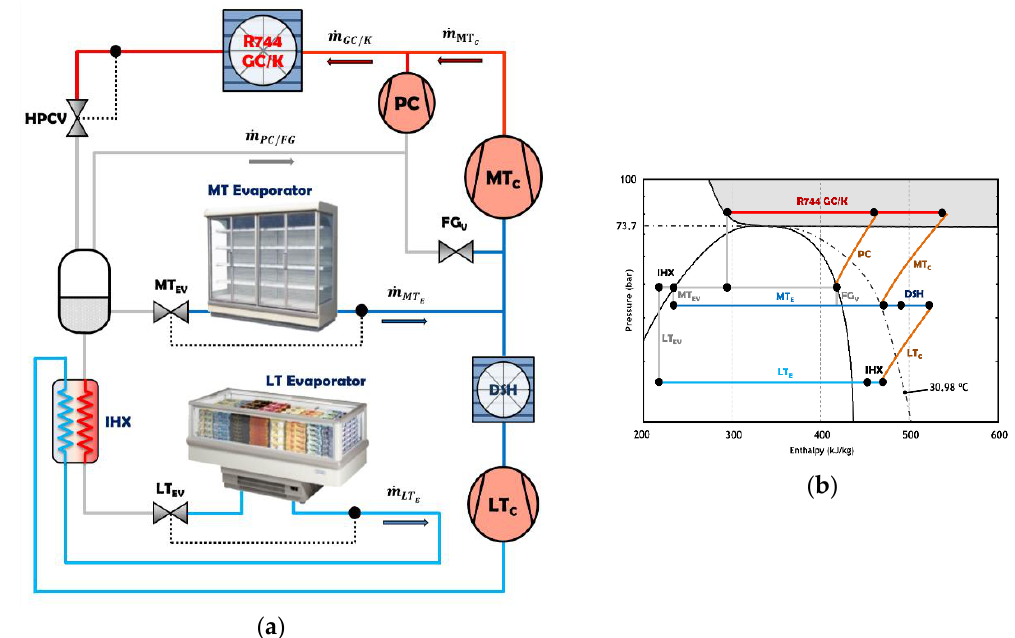
Figure 3. Schematic of a booster + PC ( a ) and its p–h diagram ( b ).